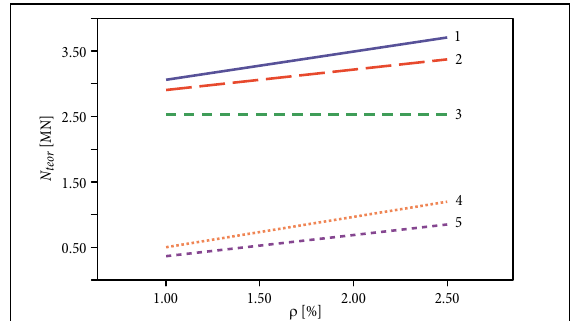
Fig. 6. The longitudinal reinforcement ratio ρ, the dependence on theoretical axial force N teor calculated by a different calculation algorithm by Eq. (7) [line – 1] and Eq. (6) [line – 2], where the carrying capacity of concrete N c [line – 3] and longitudinal reinforcement N f ( b ) [line – 4] and N f ( a ) [line –